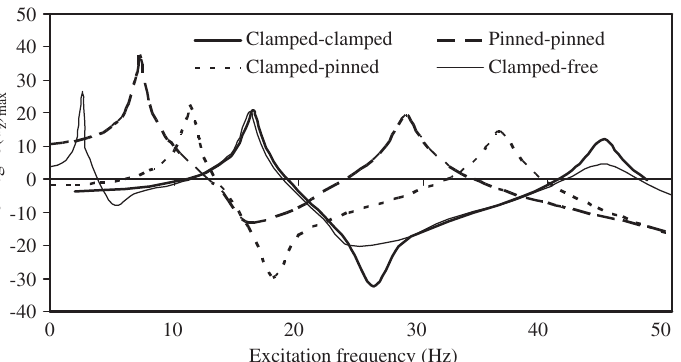
Figure 6 Frequency responses of the composite beams with [45/-45]s lay-up calculated for the point x = 0.25 L when the harmonic excitation = 0.25 L , ζ = is applied at x F